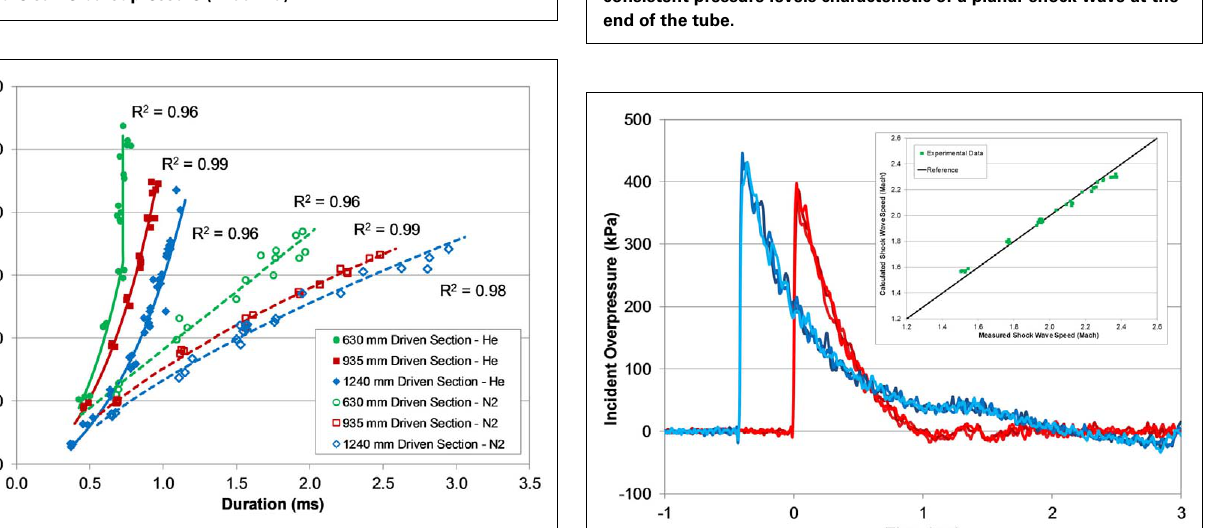
FIGURE 5 | Pressure–duration curves for the different shock tubes and driver gas, demonstrating a wide range of short-duration blast overpressures.